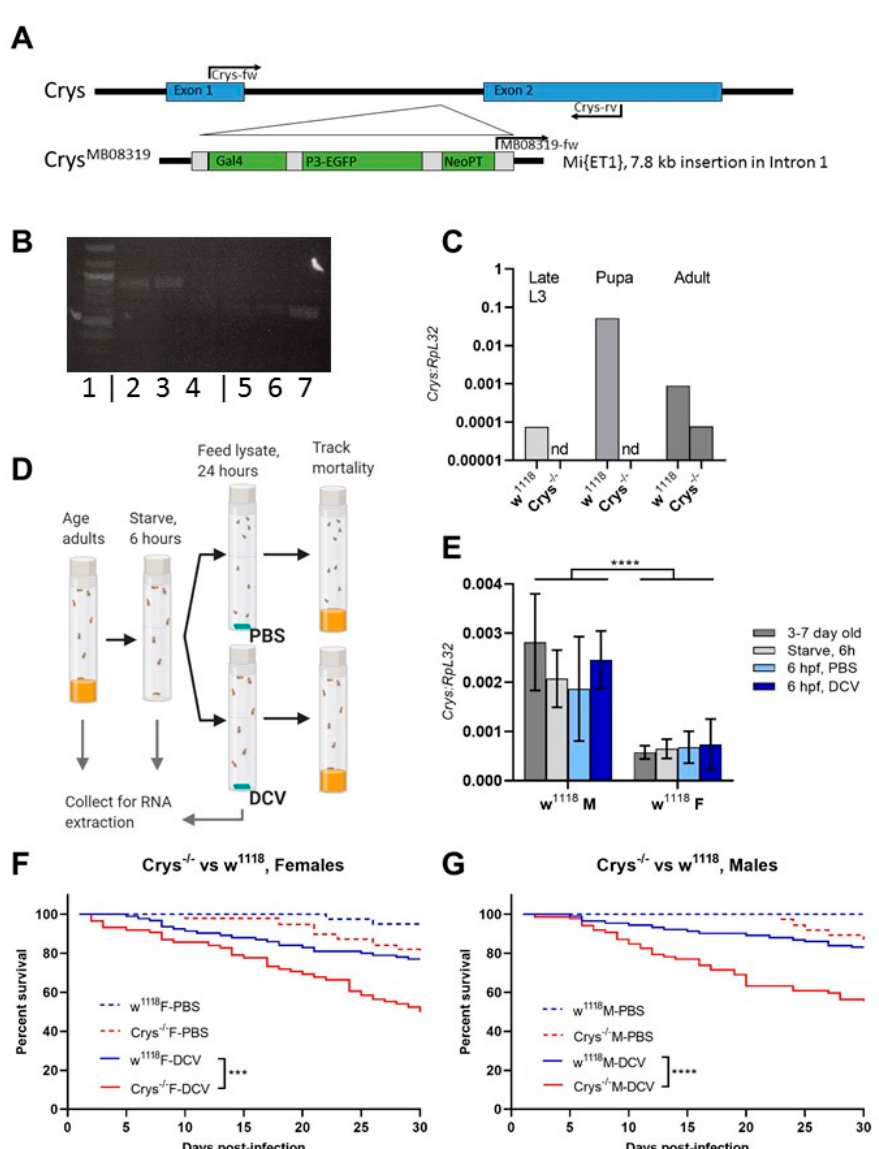
Figure 3. The loss of Crys increases the susceptibility to oral viral infection in adult flies: ( A ) the Crys − / − line originates from a 7.8kb Minos-mediated insertion within intron 1 of the Crys gene, Mi{ET1} [61,62]. Primers for Crys used in this study were designed for differentially amplifying the Mi{ET1} insertion, the wild-type Crys gene, and cDNA obtained from processed mRNA. ( B ) The insertion was confirmed by conventional PCR (1: 100bp DNA ladder; 2, 3, 4: wild-type Crys gene in w 1118 , Champetieres, and Crys − / − , respectively; 5, 6, 7: Crys MB08319 in w 1118 , Champeti è res, and Crys − / − , respectively). ( C ) A decreased or total loss of mRNA expression [24] was confirmed by RT-qPCR in pools of wandering larvae, pupae, or 1-day-old adults of w 1118 and Crys − / − , and ‘nd’ signifies none-detected. Relative expression of Crys to RpL32 was